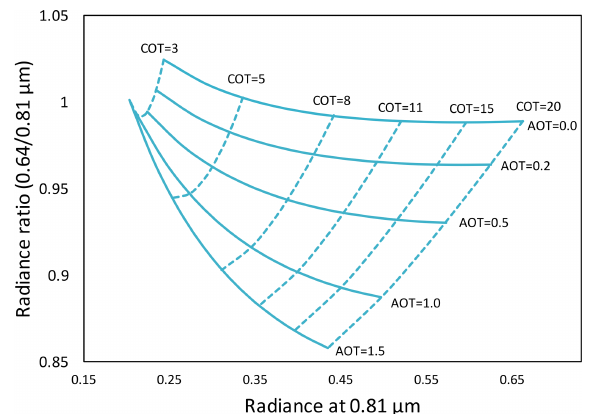
Figure 1. Radiance ratio R 0 . 64 /R 0 . 81 as a function of the radiance at 0.81µm for absorbing aerosols above clouds simulated with the adding–doubling method (De Haan et al., 1987). COTs and AOTs are indicated at